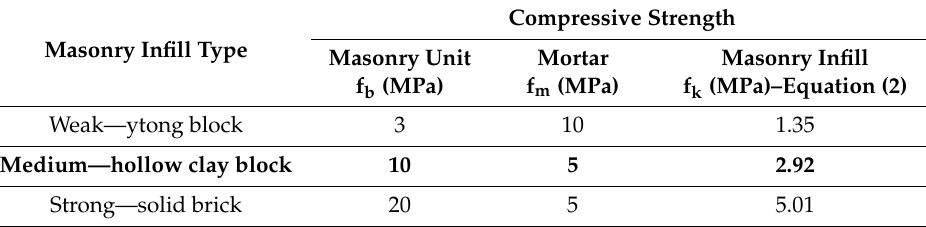
Table 6. Definition of masonry infill type based on the compressive strength.